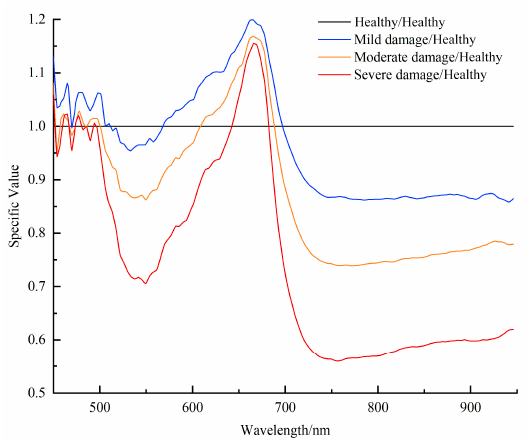
Figure 8. Spectral ratio curves of Yunnan pine canopy.